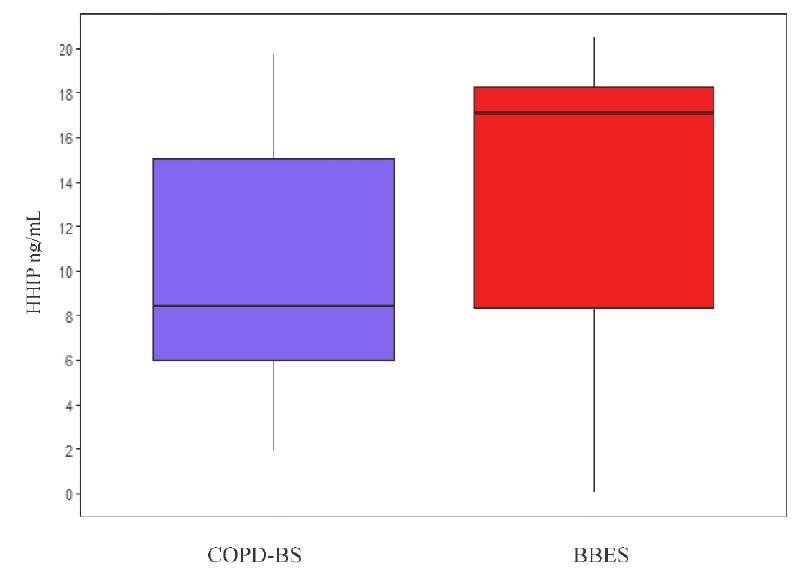
Figure 5. Comparison of HHIP protein in supernatant sputum levels among COPD-BS 4.